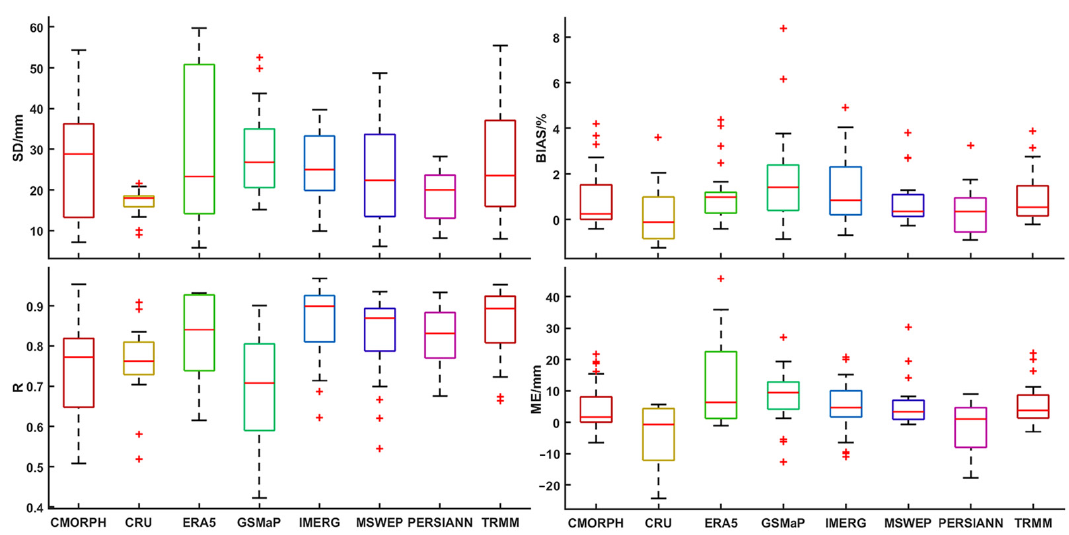
Figure 13. Box plots of four indices of monthly precipitation estimates from each product over the HRB during 2016–2019.